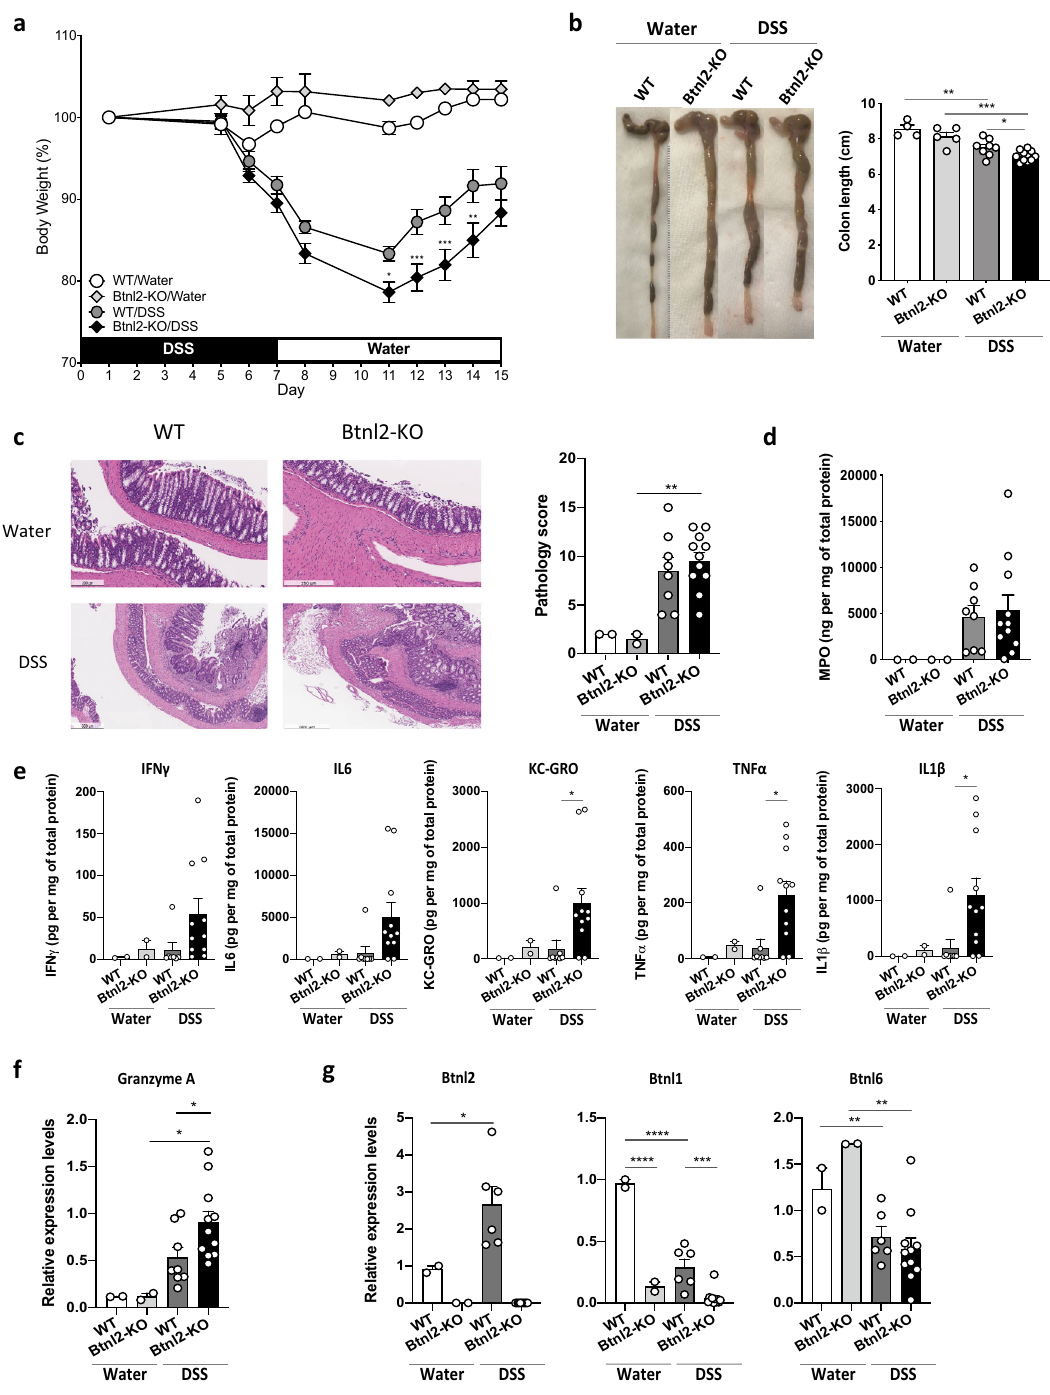
Fig. 7 Btnl2-KO mice exhibit more severe intestinal in fl ammation in chronic DSS-induced colitis. Cohoused 15-week-old Btnl2-KO ( n = 11) and WT ( n = 8) littermates were subjected to 3% DSS-induced colitis for 7 days followed by water for 8 days. Control mice ( n = 2 – 4) received water. a Body weight loss in cohoused Btnl2-KO and WT littermates calculated as the percent difference between the initial and actual body weight on the above days. Error bars represent mean ± SEM. Signi fi cance is measured using unpaired t -tests assuming similar SD, * p < 0.05, ** p < 0.005, *** p < 0.0005, signi fi cantly different from DSS-treated WT mice. b Colon length of water- and DSS-treated Btnl2-KO and WT mice on day 15. c H&E histological sections and a pathological score of the colon from water- and DSS-treated Btnl2-KO and WT mice. Scale bars are 200 μ m (WT/water), 250 μ m (Btnl2-KO/water), 500 μ m (WT/DSS and Btnl2-KO/DSS). d Myeloperoxidase (MPO) activity in colon homogenates of water- and DSS-treated Btnl2-KO and WT mice. e Levels of pro-in fl ammatory cytokines in colon homogenates of water and DSS-treated Btnl2-KO and WT mice. f Granzyme A mRNA levels in colon homogenates of water- and DSS- treated Btnl2-KO and WT mice, normalized to β 2m. Error bars represent mean ±SEM. Signi fi cance is measured using unpaired t-tests assuming similar SD, * p < 0.05. g Btnl1/2/6 mRNA levels in the colon of water- and DSS-treated WT mice, normalized to β 2m. Error bars represent mean ±SEM. Signi fi cance is measured using one-way ANOVA, * p < 0.05, ** p < 0.005, *** p <